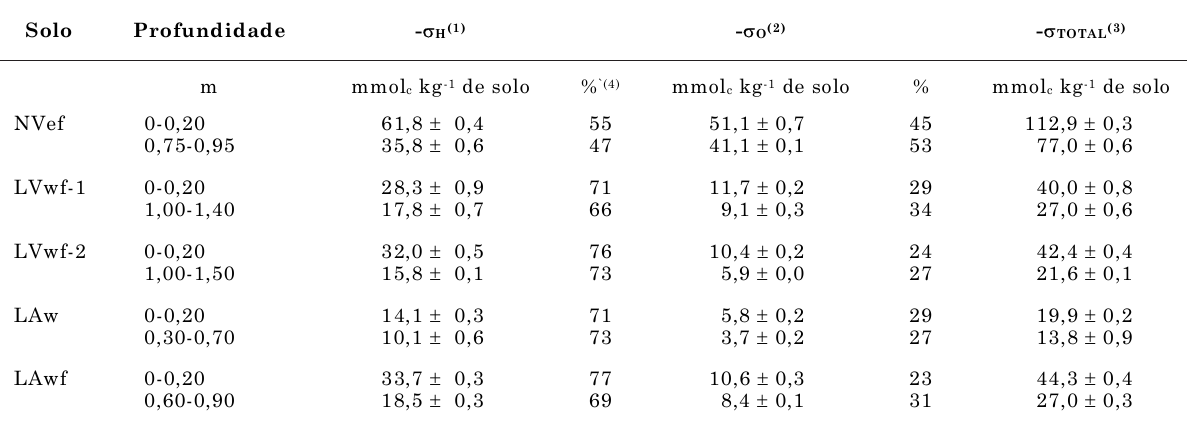
(1) σ = adsorção do íon Cs + para os sítios de carga variáveis. (2) σ H adsorção do íon Cs + para sítios de carga total. (4) % = percentagem em relação ao total. NVef = Nitossolo Vermelho eutroférrico; LVwf-1 = Latossolo Vermelho acriférrico textura argilosa; LVwf-2 = Latossolo Vermelho acriférrico textura média; LAw = Latossolo Amarelo ácrico; LAwf = Latossolo Amarelo